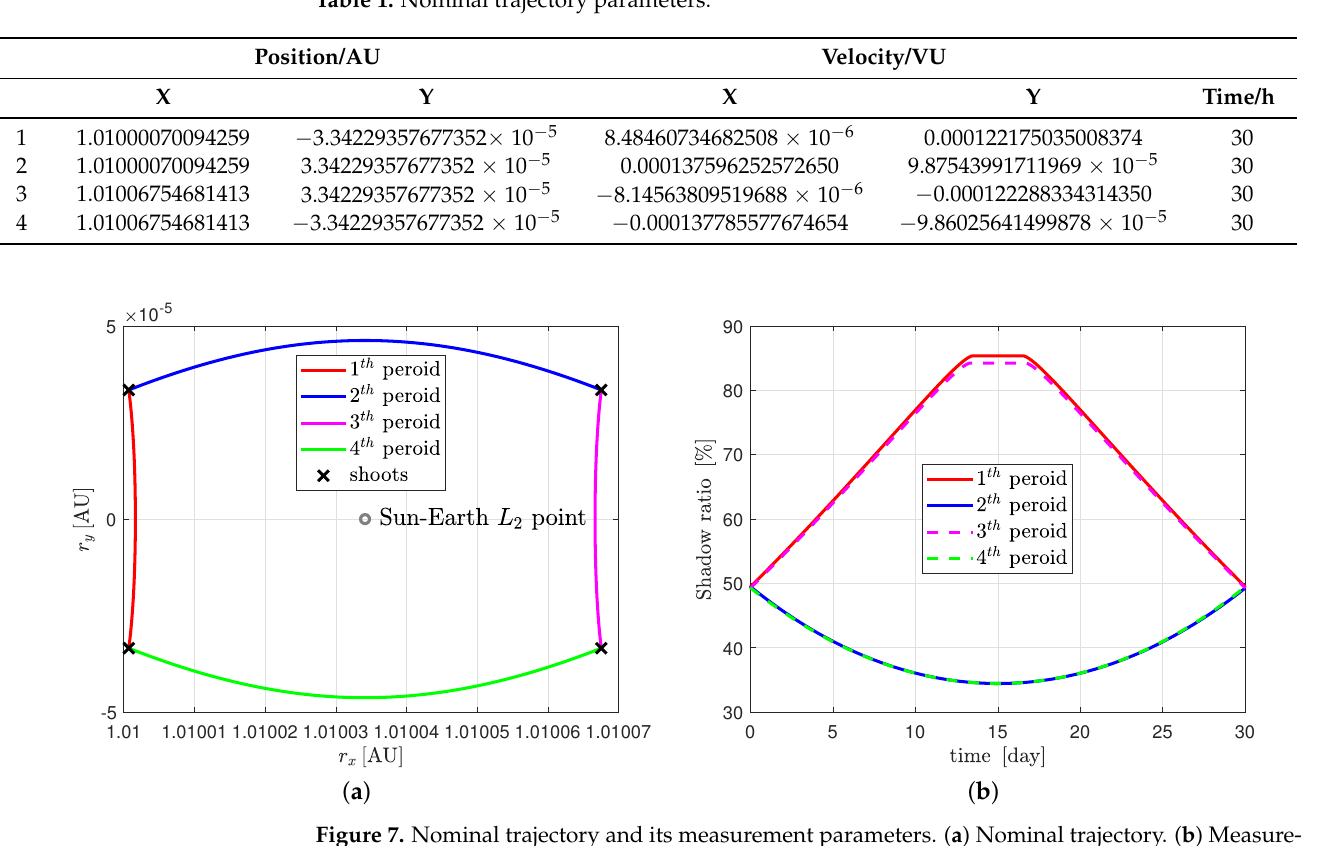
Table 1. Nominal trajectory parameters.